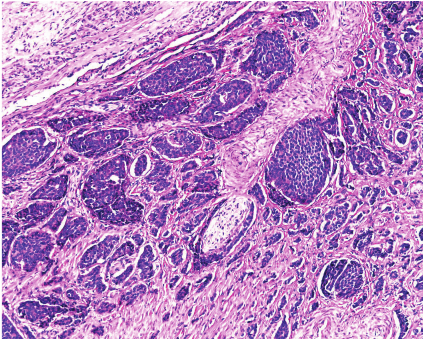
Figure 2: Small bowel carcinoid tumor invading into the subserosal tissue at 20x